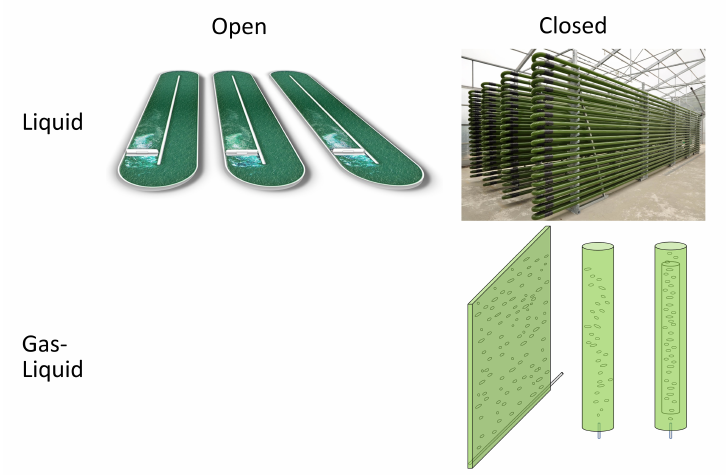
Figure 1. Classification of common photobioreactor types. Top left: Open Raceway Pond ([56], published under CC-BY-SA-4.0 license). Top right: Tubular photobioreactor PBR 4000G, IGV Biotech ([57], published under CC BY-SA 3.0 license). Bottom right: Flat-panel Airlift photobioreactor, Bubble Column photobioreactor, Airlift photobioreactor (own